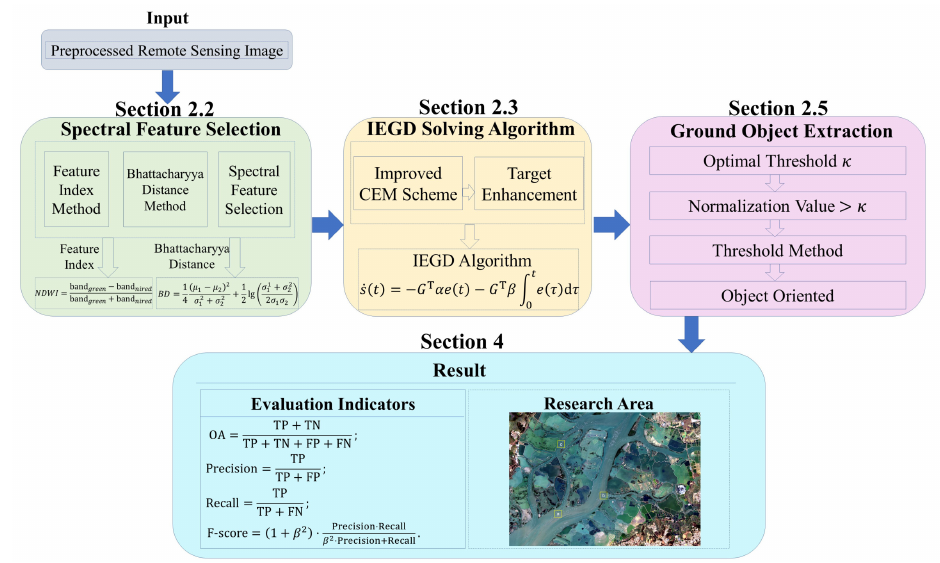
Figure 1. Technical route of harbor aquaculture area